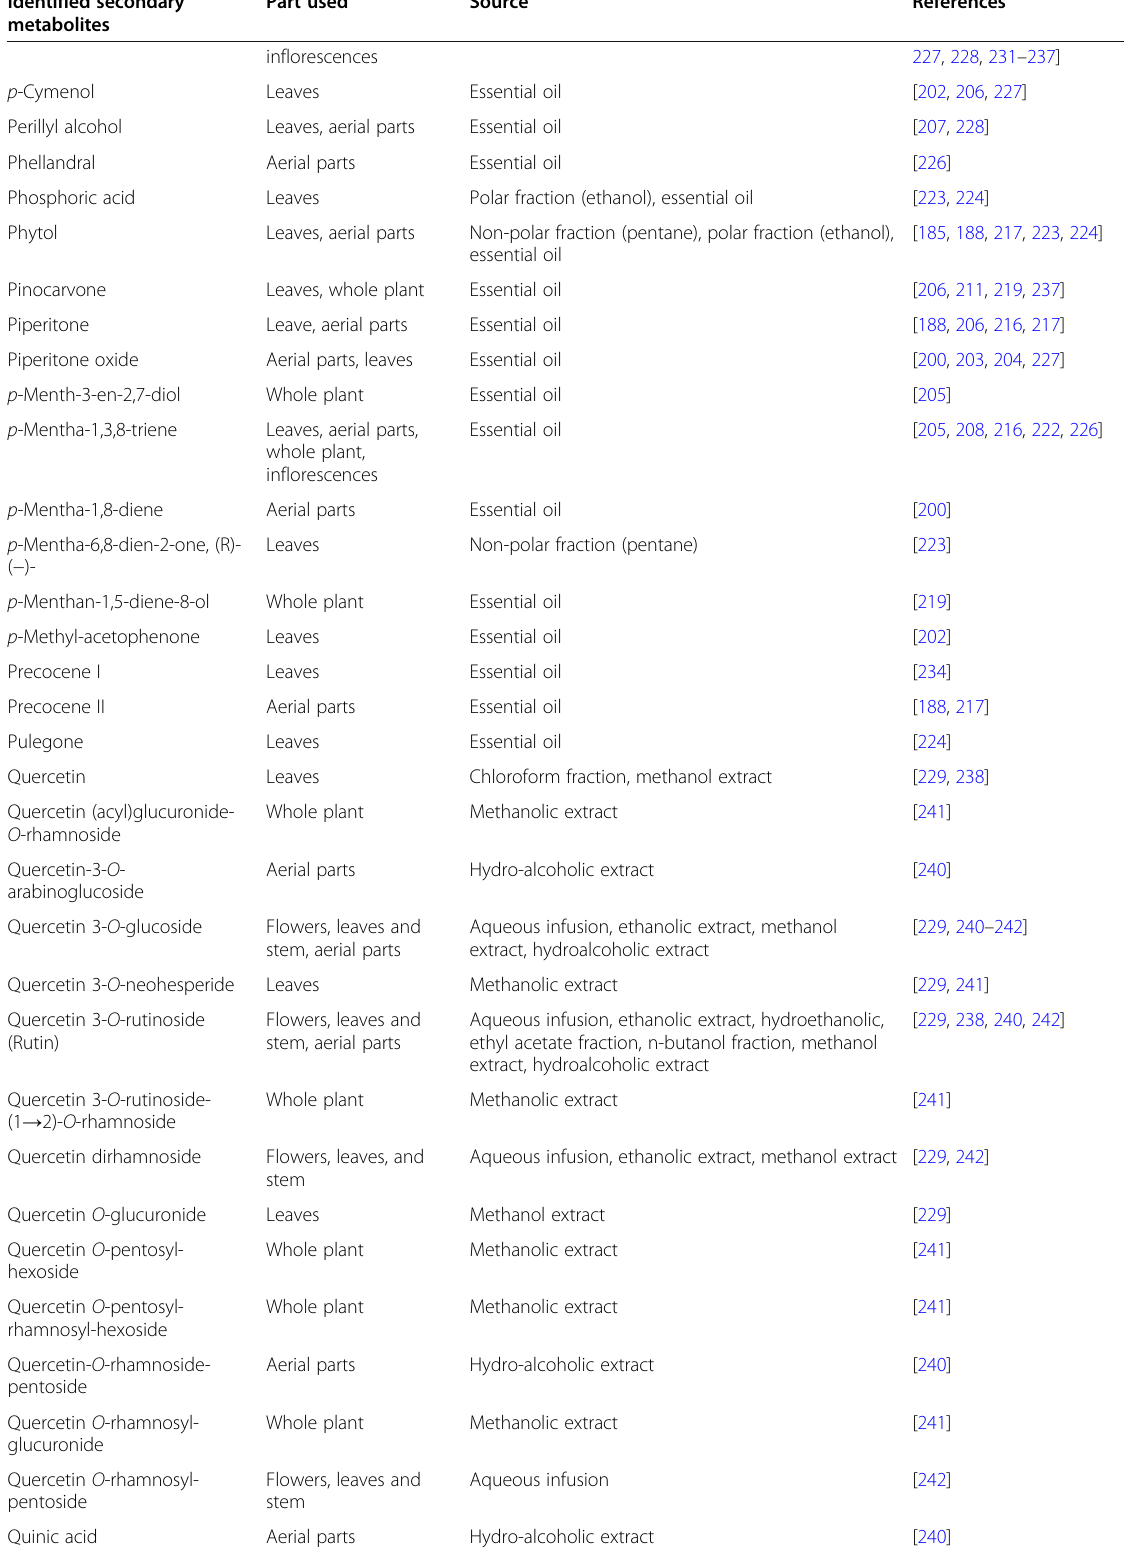
Table 3 Main secondary metabolites identified in C. ambrosioides